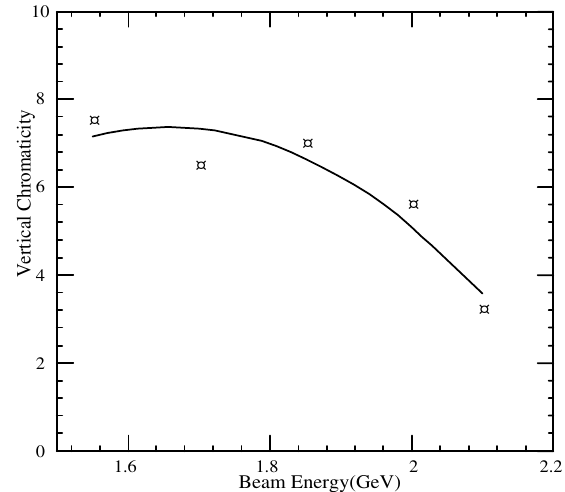
FIG. 3. Energy dependence on the chromaticity at the thresh- old value.